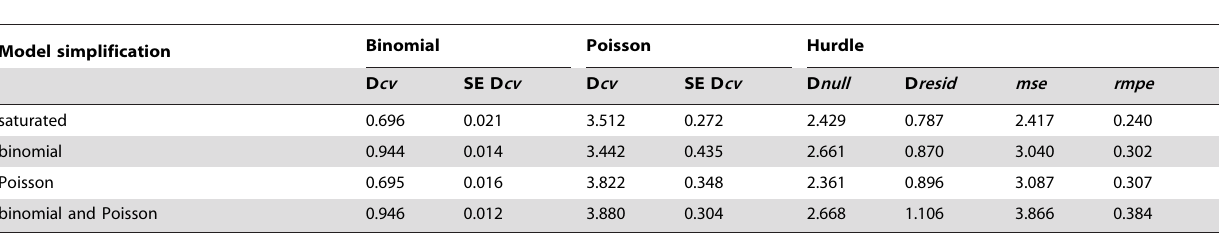
Table 3. Results of the hurdle boosted regression tree simplification